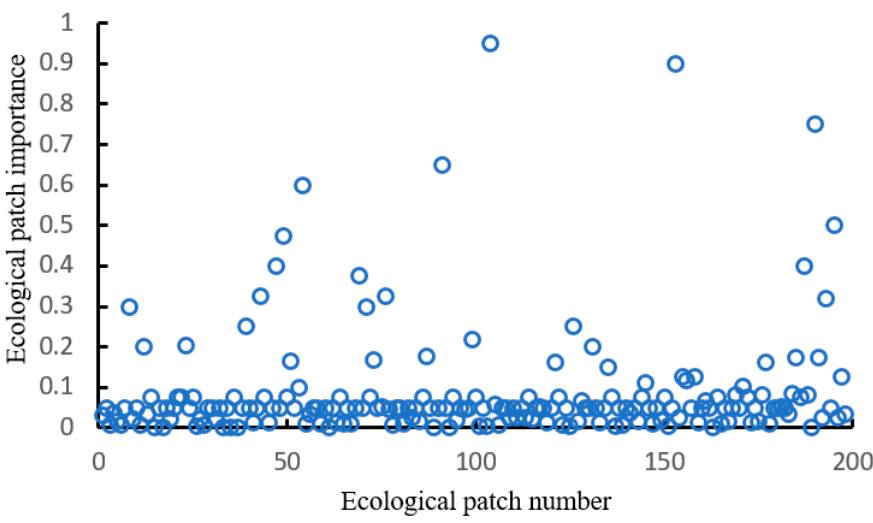
Figure 3. Statistical map of the importance of ecological source sites Q.